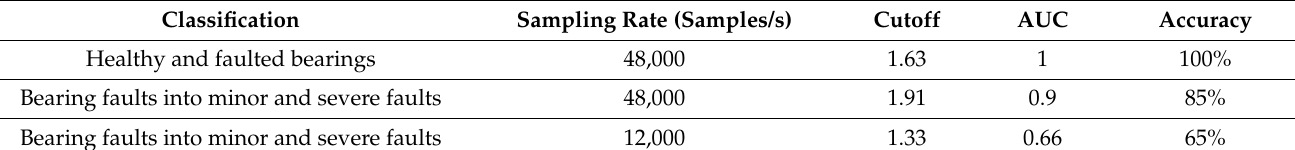
Table 4. Diagnostic performance of the proposed method using detrended fluctuation analysis (DFA).